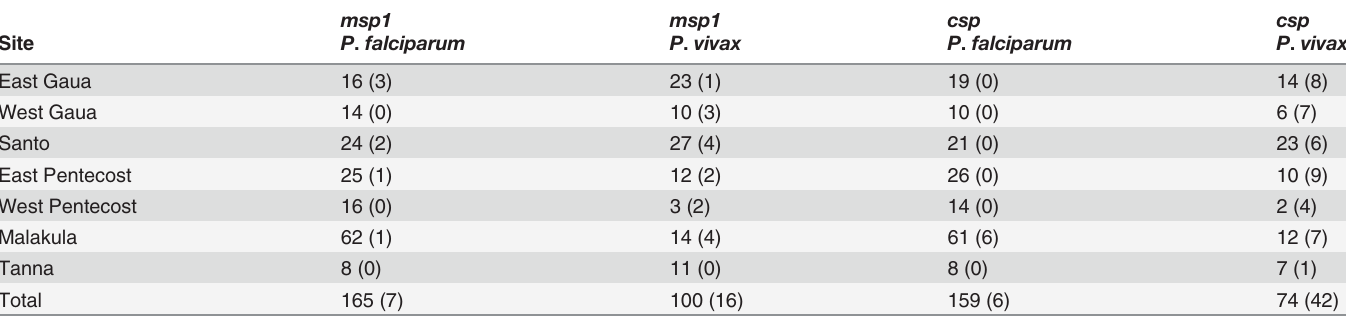
Table 1. Numbers of merozoite surface protein 1 ( msp1 ) and circumsporozoite protein ( csp ) sequences from seven sites in Vanuatu.